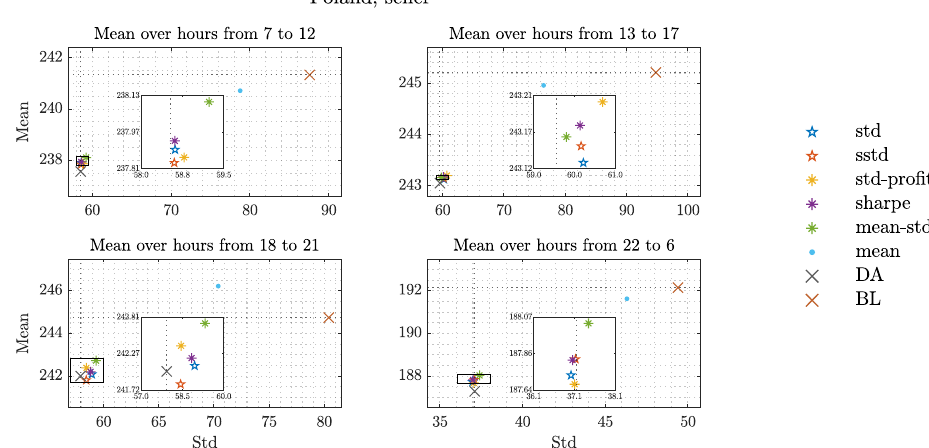
Figure 9. Average results of the portfolio allocation, ( σ h , t , E [ s h , t ]) obtained for a seller in the Polish market using different strategies. The averages are calculated over all days in the validation window and hours within the considered blocks: 7–12, 13–17, 18–21, 22–6. The results of trading only on the day-ahead (DA) or balancing (BL) market are plotted for reference. To improve visibility, a zoom from the area marked with rectangles is also plotted. Source: Authors’ elaboration.